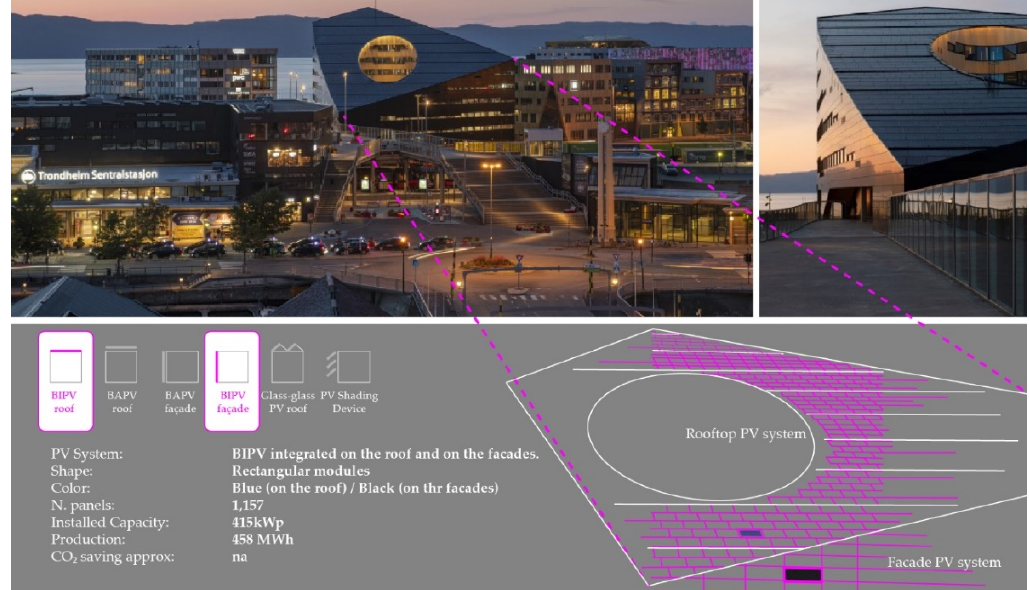
Figure 8. Powerhouse Brattørkaia (photo on top by Ivar Kvaal, with permission from Powerhouse http://powerhouse.no) ( on the top ); Integration and characteristics of PV systems ( on the bottom